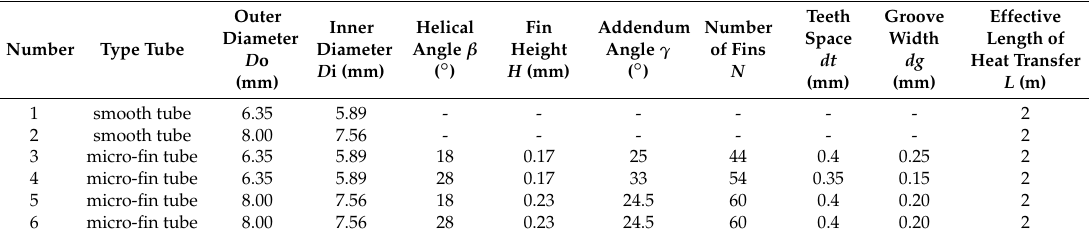
Figure 3. ( a ) Temperature-measuring module and ( b ) pressure-measuring module.